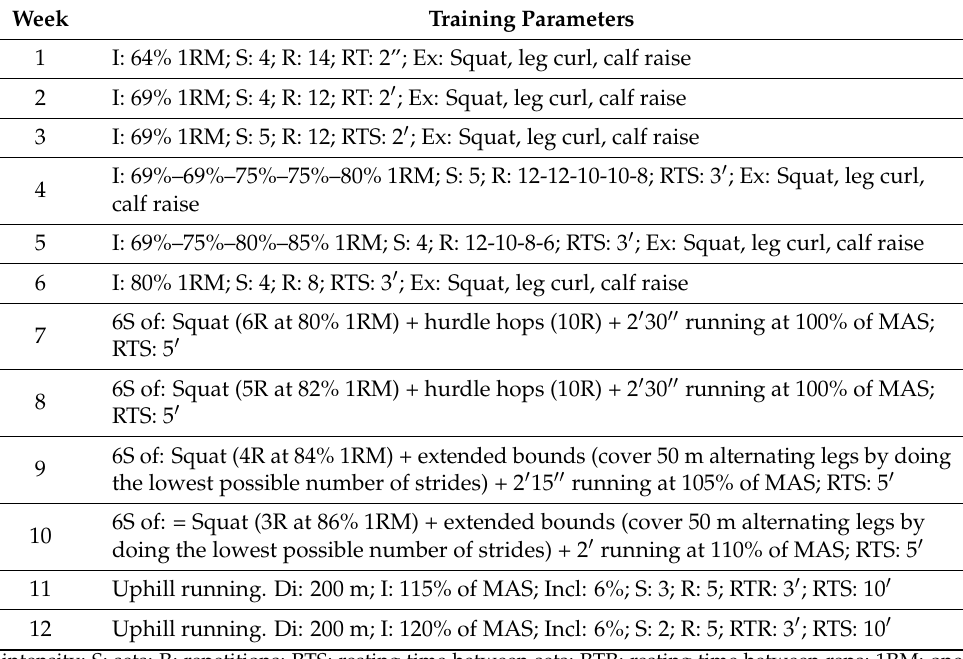
Table 1. Training methodology that will be used with RSSTG.